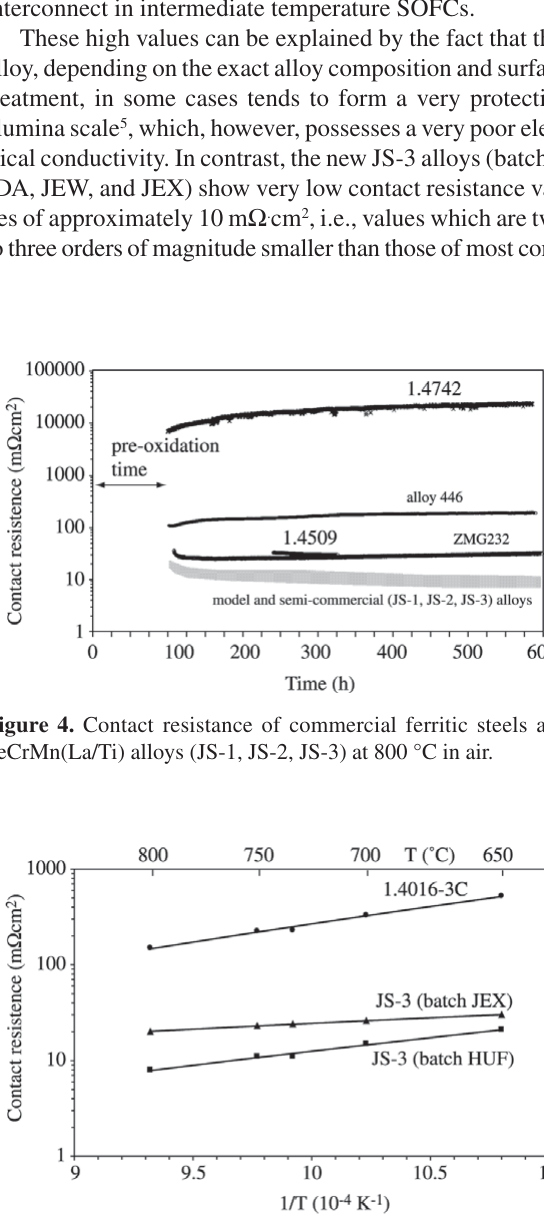
Figure 5. Contact resistance of the oxide scales formed on various ferritic steels as function of